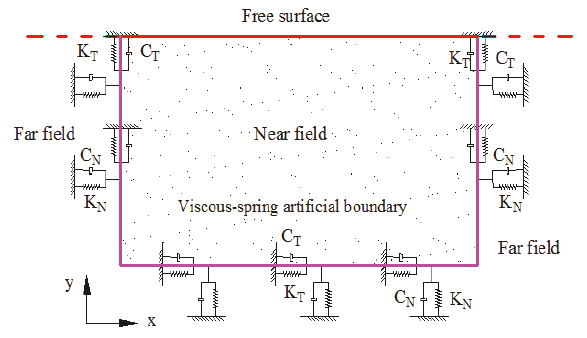
Figure 6: Elastic half-space